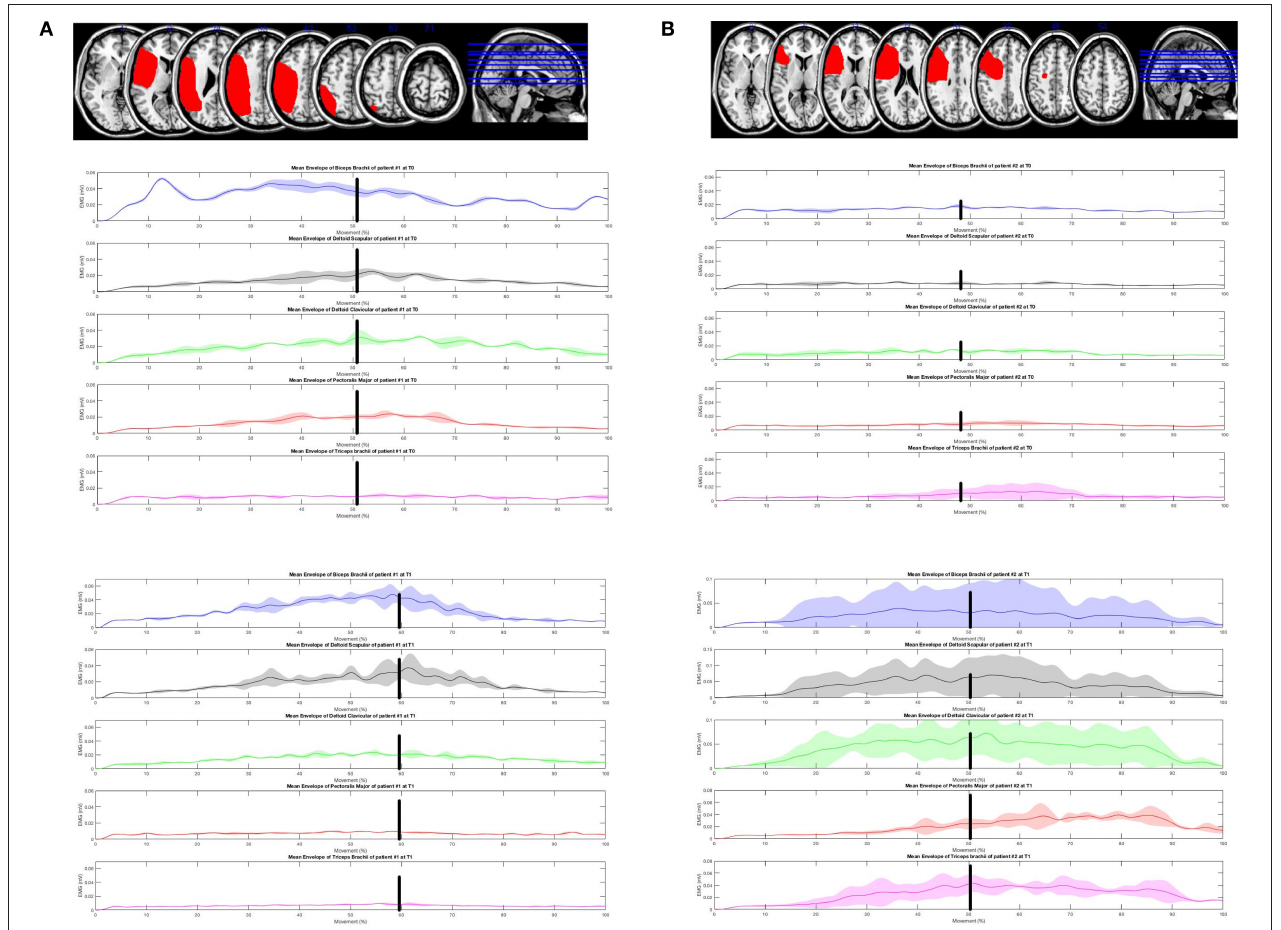
FIGURE 5 | Lesions displayed on the magnetic resonance imaging brain template and electromyographic activity of the five upper limb muscles during the “hand-to-mouth” task was explored using a surface Electromyography (EMGs) in two patients. (A) Top left: Lesion Mapping (patient 1). Magnetic resonance imaging showed a lesion involving the left fronto-parietal lobes. Brodmann areas 48, 40, 39, 6, 44, 45, 3, 7, 22, 41, 2, 42, 4, 19, 43, 37, 21,47,9, 46, 1, 18, 23, 10 (MRIcron software, http://www.mricro.com/mricron). The electromyographic activity of the 5 UL muscles during the “hand-to-mouth” task was explored using a surface Electromyography (EMGs). (B) Top right: Lesion Mapping (patient 2). Magnetic resonance imaging showed a lesion involving the left frontal lobe. Brodmann areas 48, 45, 44, 6, 46, 43, 4, 3, 47, 32, 9, 38, 22, 10 (MRIcron software, http://www.mricro.com/mricron). The electromyographic activity of the 5 UL muscles during the “hand-to-mouth” task was explored using a surface Electromyography